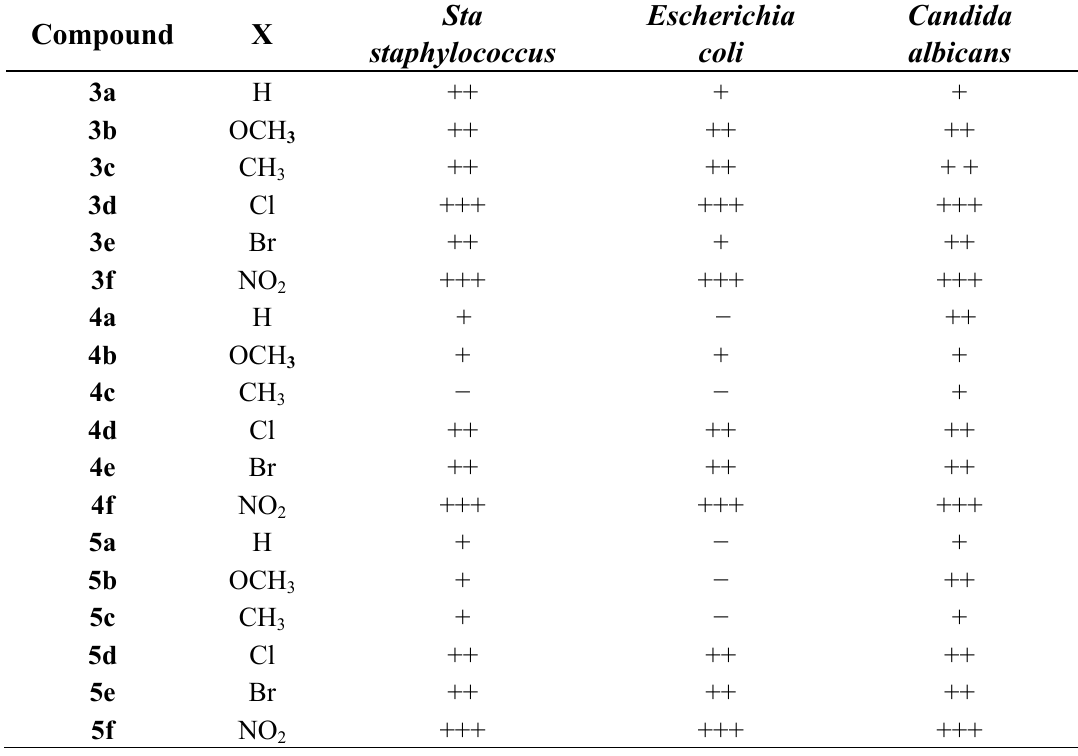
Table 3. Antimicrobial activities of newly synthesized compounds 3–5 .